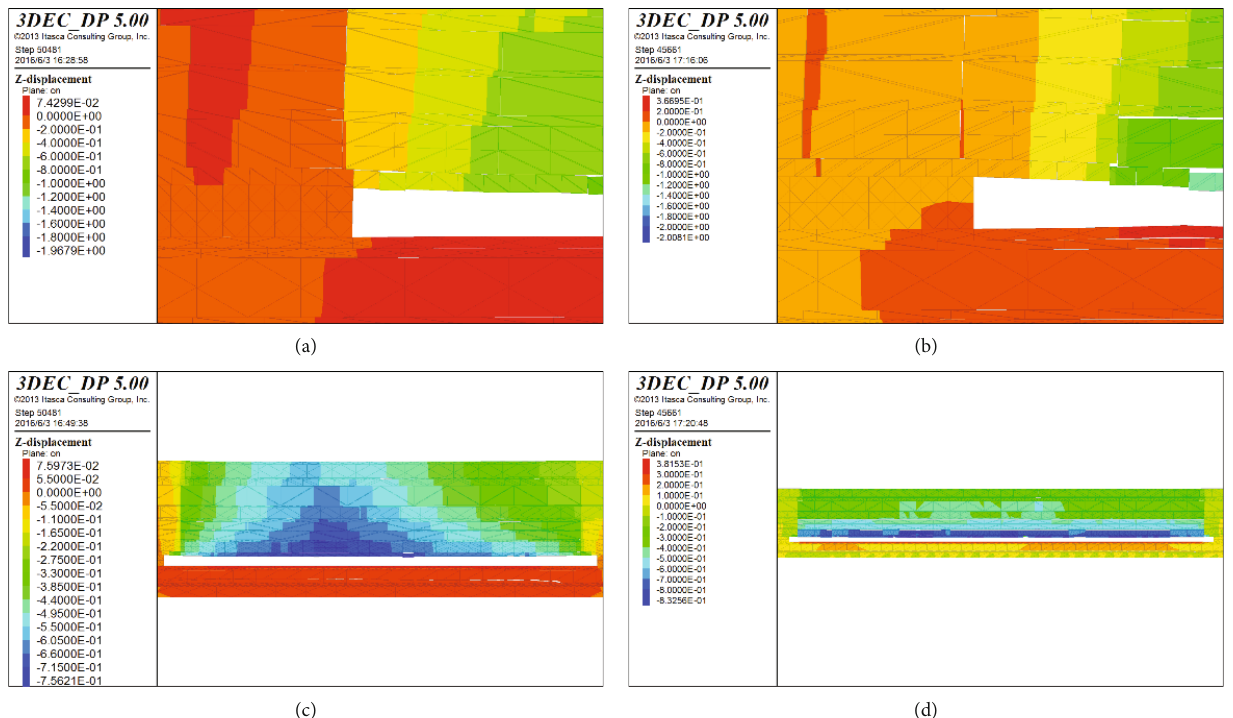
Figure 9: Nephogram of roof strata displacement when advancing to 45 m(unit: m): (a) slice of the 195m working face in advancing direction, (b) slice of the 376m working face in advancing direction, (c) lengthwise slice of the 195m working face, and (d) lengthwise slice of the 376m working